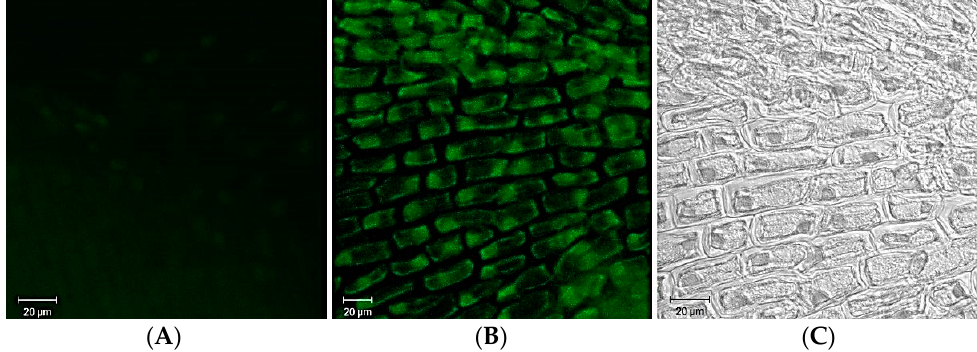
Figure 4. Confocal microscopy image of Allium cepa epidermal root cells. Exposure time 24 h: ( A )—untreated cells; ( B )—cells treated with Ag 2 S QDs; ( C )—cells under transmitted light.